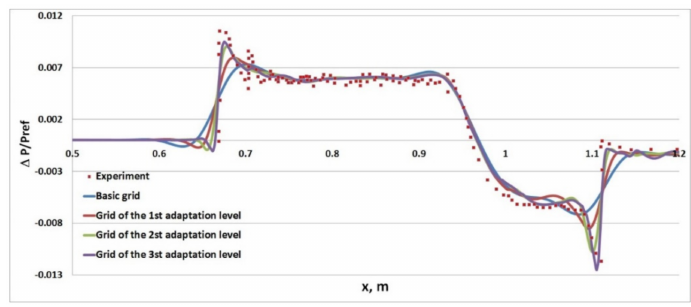
Figure 17. Normalized variation of static pressure.